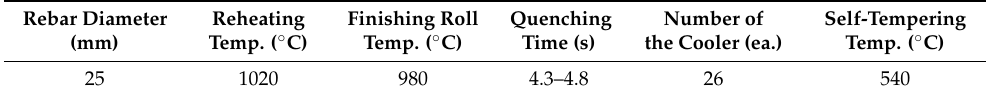
Table 2. Tempcore process conditions of rebars used in this study. Rebar Diameter